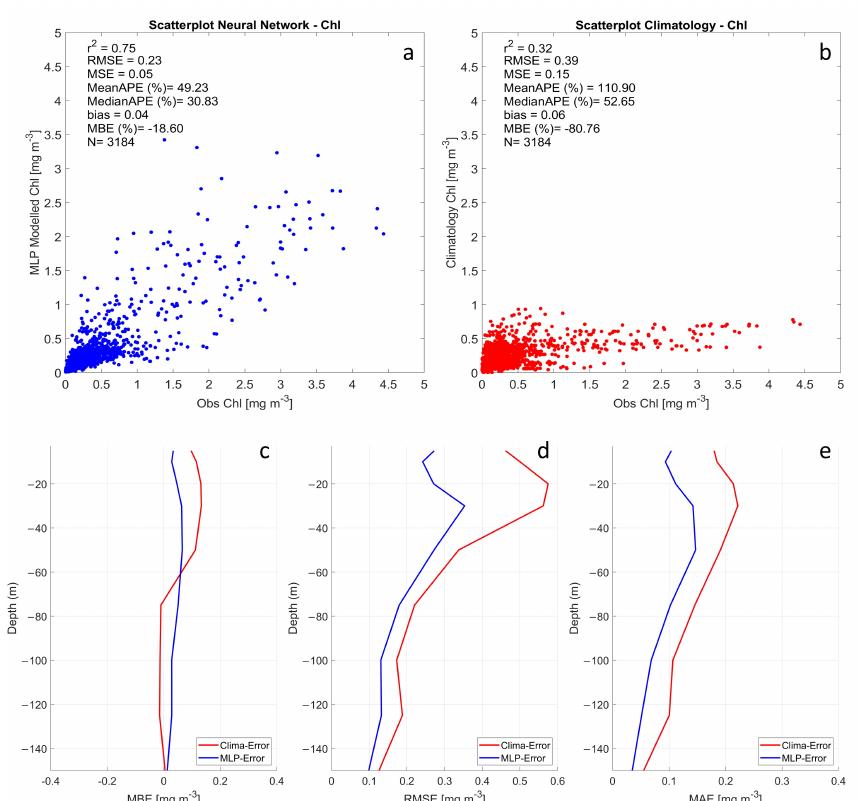
Figure 10. Results of the chlorophyll comparison between the MLP performance (in blue) and MEDATLAS climatology (in red) on test set. In the upper left panel ( a ), a scatterplot of the observed values (on x-axis) vs. MLP predictions (on y-axis) is shown (blue dots). As a counterpart (red dots), the upper right panel ( b ) shows the scatterplot of the comparison between the observed values (on x-axis) and climatology (on y-axis). The relative statistics is given in each panel, with N as the number of available data for the matchups database. Bottom panels show the MBE ( c ), RMSE ( d ) and the MAE ( e ) in function of depth for the MLP (blue line) and climatology (red line) comparison. For chlorophyll the reference MEDATLAS climatology is the seasonal